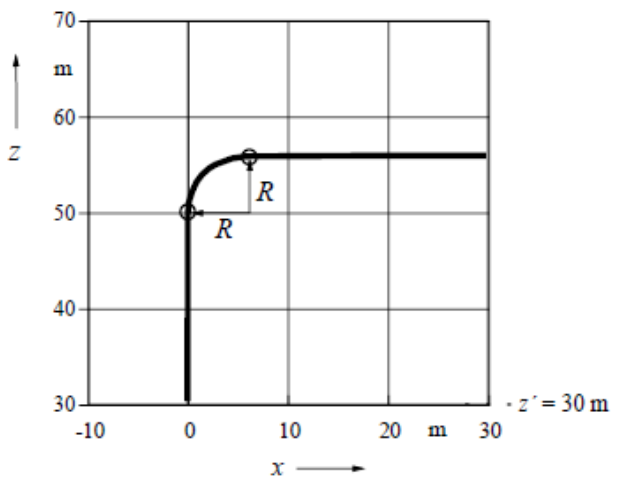
Figure 9. line source with a 90° bend with the bending radius R and a depth of y = 2.0 m.